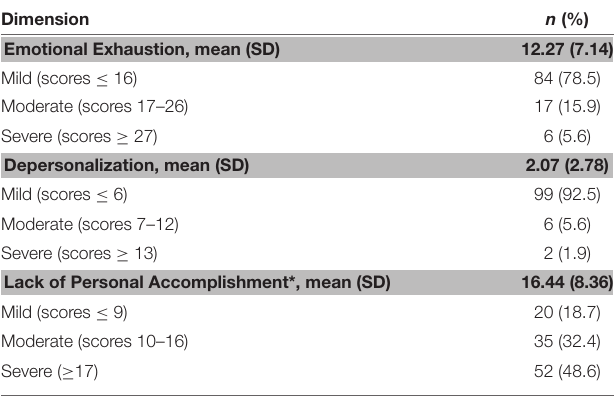
Frontiers in Psychiatry |